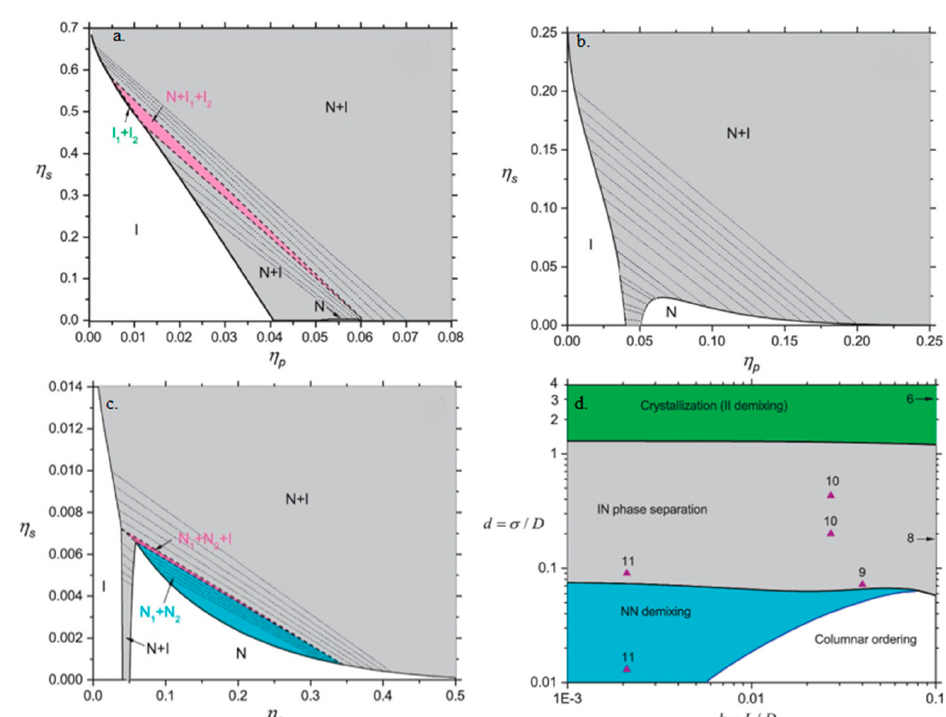
Figure 14. Effects of spheres on the phase behavior of platelets. η s = fraction of spheres , η p = fraction of platelets , σ = sphere diameter, D = platelet lateral diameter. In (a–c), k = L/D = 0.01 and the coexisting isotropic (nematic) phases are labeled as I 1 and I 2 (N 1 and N 2 ). The two-phase and three-phase regions are indicated by gray (I–N), green (I 1 –I 2 ), cyan (N 1 –N 2 ), and pink (I–N 1 –N 2 and I 1 –I 2 –N). ( a ) σ / D = 1.3, ( b ) σ / D = 0.2, and ( c ) σ / D = 0.03. ( d ) Phase diagrams of sphere-plate mixtures shown in the diameter ratio–aspect ratio ( σ / D–L / D ) plane. Regions of the phase diagrams are coloured di ff erently: (1) The phase diagram is dominated by strong fractionation and reentrance of isotropic–nematic phase transition (gray), (2) the region of isotropic–nematic and isotropic–crystal transition, where the isotropic–isotropic demixing is not stable (green), (3) the region of nematic–nematic demixing and isotropic–nematic transition (cyan) and (4) those systems where the nematic–nematic demixing is unlikely to occur and is replaced by isotropic–columnar transition (white). The molecular parameters of some experimental systems are highlighted by triangle symbols and the numbers refer to their references. Modified from Aliabadi, R.; Moradi, R.; Varga, S. Tracking three-phase coexistences in binary mixtures of hard plates and spheres. J. Chem. Phys. 2016, 144, 074902, with the permission of AIP Publishing [111].